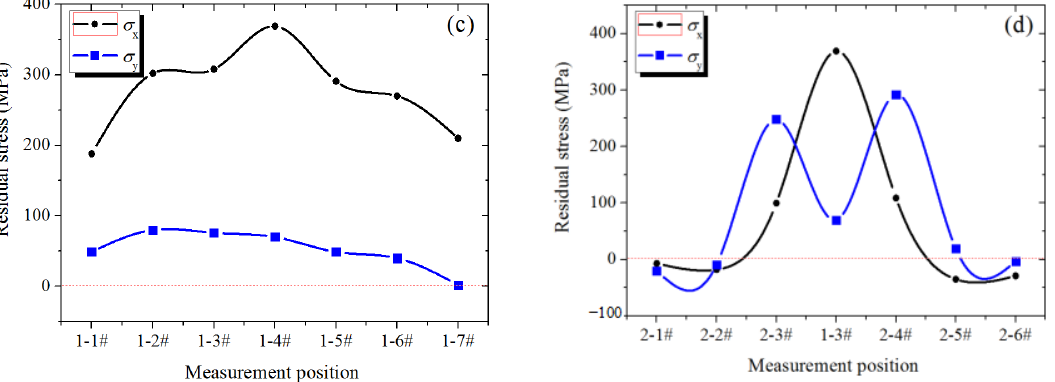
Figure 8. Residual stress measurement results in front surface—( a , b ) and in back surface—( c , d ).